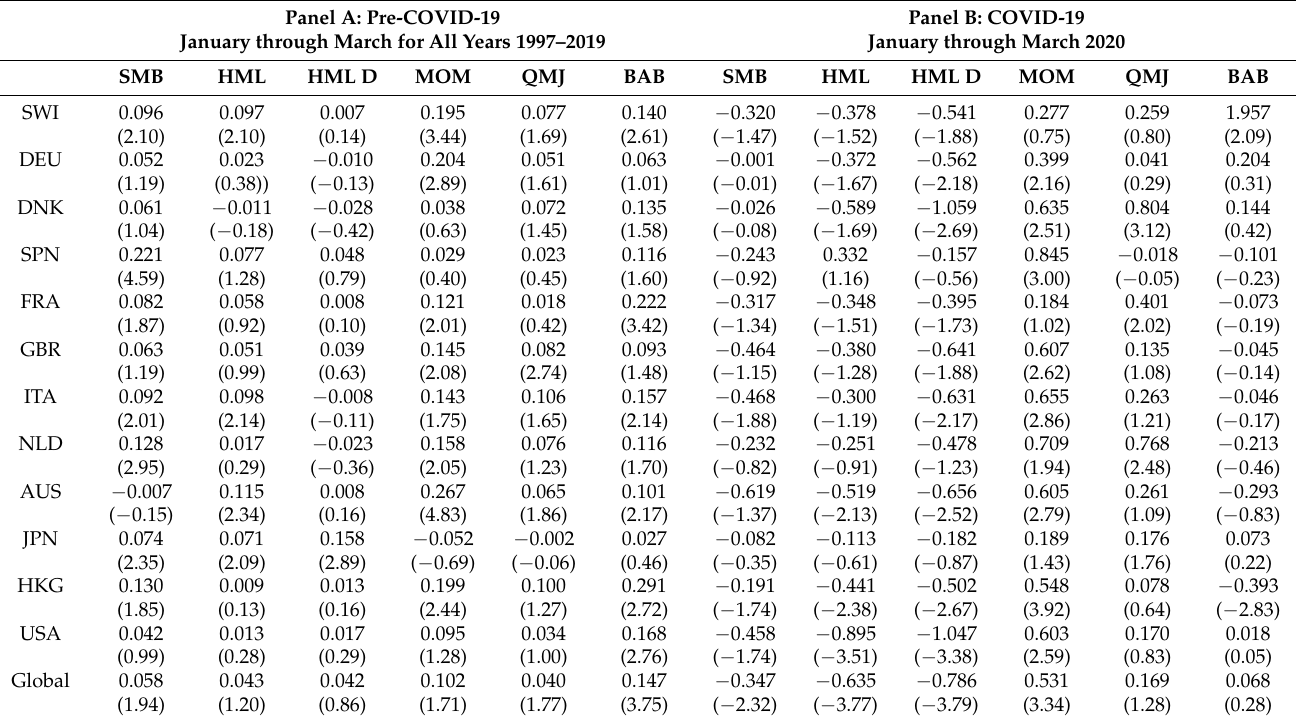
Table 4. Annualized CAPM